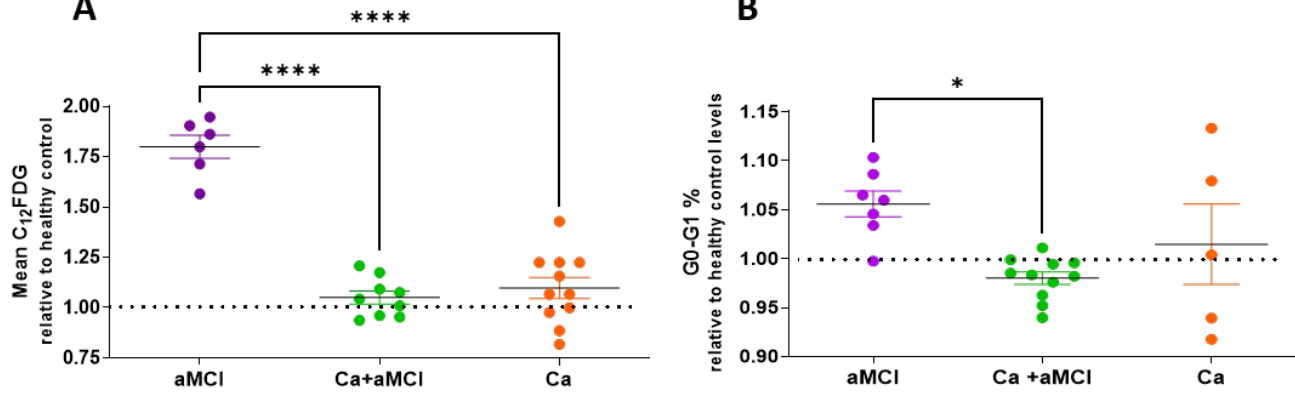
Figure 2. Senescent SA- β -Gal marker and growth arrest in PBMCs Ca + aMCI patients were lower than in aMCI patients and like those of cognitively normal Ca survivors and healthy controls. Values are mean C12FDG Units relative to healthy controls (dotted line, 18.5 ± 1.1 C12FDG Units (mean ± SE)). ( A ) SA- β -Gal activity in PBMCs of patients with Ca + aMCI (n = 9) was significantly decreased as compared with aMCI (n = 6), while cognitively normal cancer survivors (Ca, n = 11) had levels comparable to the Ca + aMCI group, both not different from healthy controls. ( B ) Growth arrest of PBMCs was determined by the percentage of cells at cell-cycle stage G0-G1 relative to the values of healthy controls (dotted line, 81.5 ± 1.3% (mean ± SE)). The percentage of PBMCs arrested at G0-G1 in Ca + aMCI (n = 11) patients was lower than in aMCI (n = 7) patients and comparable to Ca survivors (n = 5) and healthy controls. Statistical analysis: Kruskal–Wallis with Dunn’s post hoc correction, * p < 0.05; **** p < 0.0001.